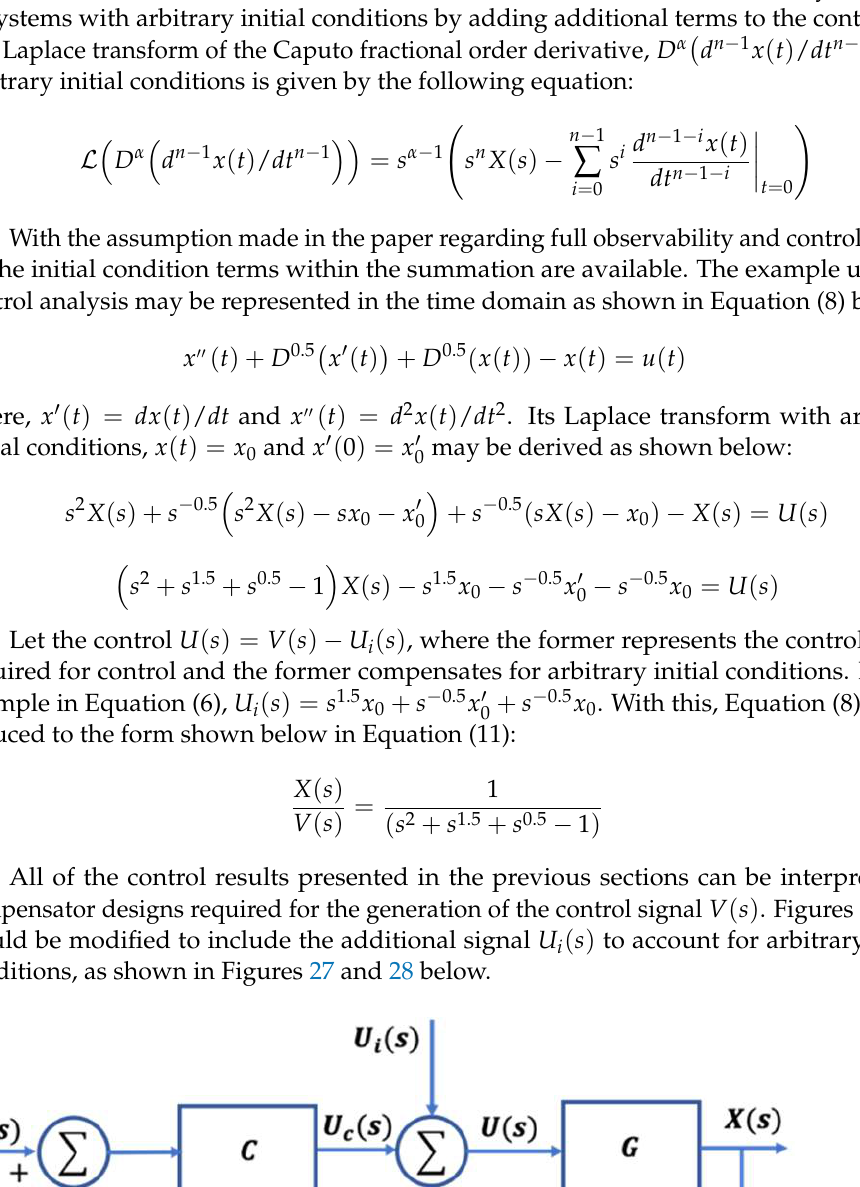
Figure 28. Transform and Control with Arbitrary Initial Conditions.